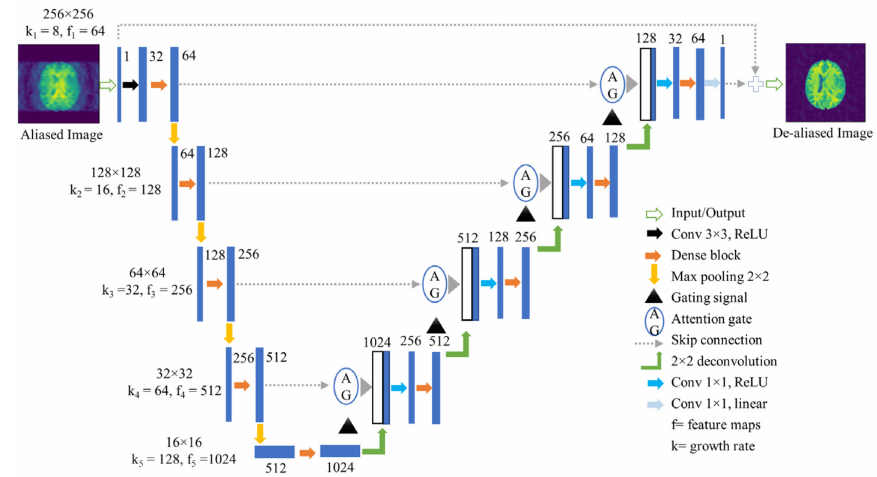
Figure 3. Proposed FDA-CNN architecture.